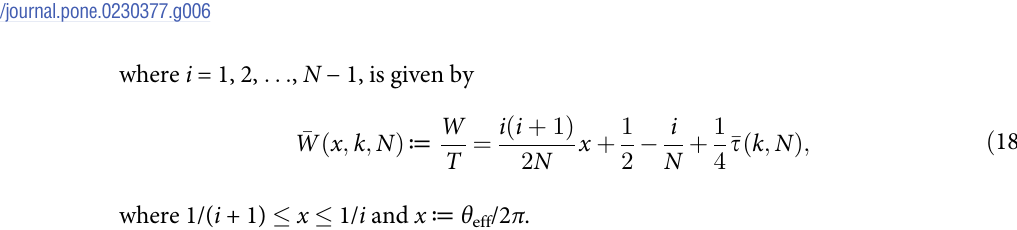
Fig 6. (a) Simulation results for N = 2, 3, 4, 5, 6, 7, 8 buses, respectively, serving M = 1 bus stop. The demand level is fixed at k = 1/16. (b) Simulation results for N = 2, 3, 4, 5, 6, 7, 8 buses, respectively, serving M = 12 bus stops. The demand level is fixed at k = 1/100. The analytical curves are for those serving M = 1 bus stop. The simulation points have average waiting times which are higher than their corresponding analytical curves, since these buses serve M = 12 bus stops. Furthermore, there are discrete jumps on the simulation points whenever an extra bus stop is present. (c) Graphs of the piecewise continuous curves for N = 2, 3, 4, 5 as given by Eq (18) with � t = 4 subtracted away, together with the corresponding smooth curves Eq (18) that pass through the boundary points of each line segment, for the respective N . These smooth curves are hyperbolas , and approach an “ L ”-shaped asymptotic curve as N ! 1 . (d) Legend for (a) and